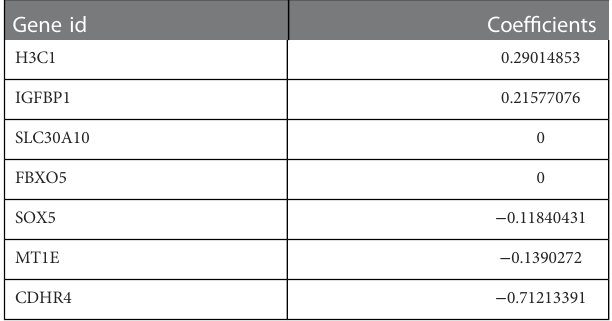
TABLE 2 The regression coef fi cients 7 CS-related prognostic